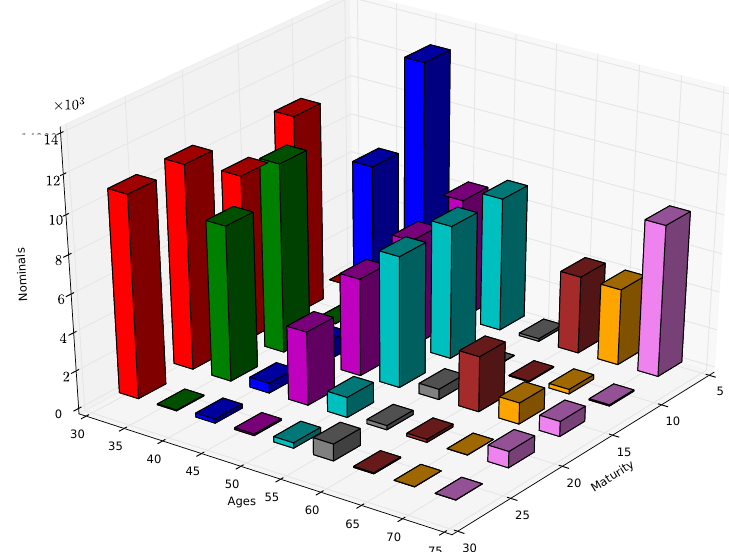
Figure 8. Computed model points portfolio for Example